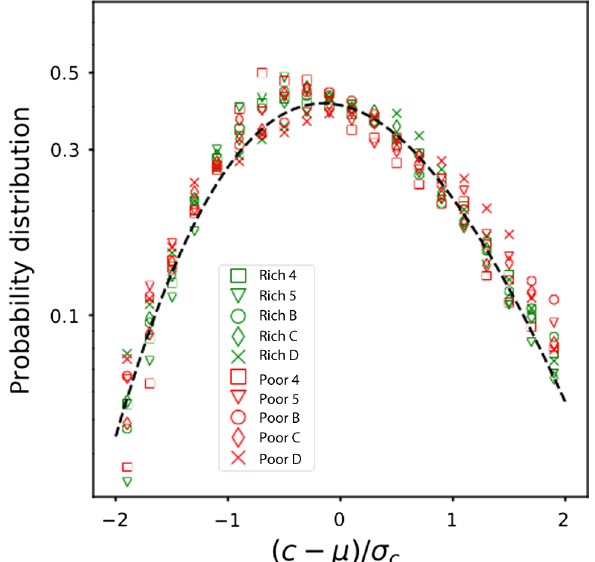
FIG. 3. Distributions of the normalized protein concentration fluctuations under different experimental conditions. The dashed line is obtained from the analytical expression Eq. (13) from our